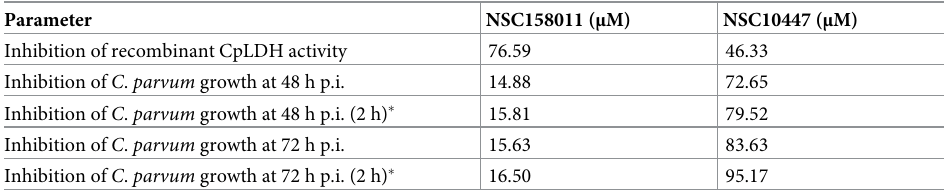
Table 3. NSC158011 and NSC10447 IC 50 values on CpLDH enzyme and C . parvum